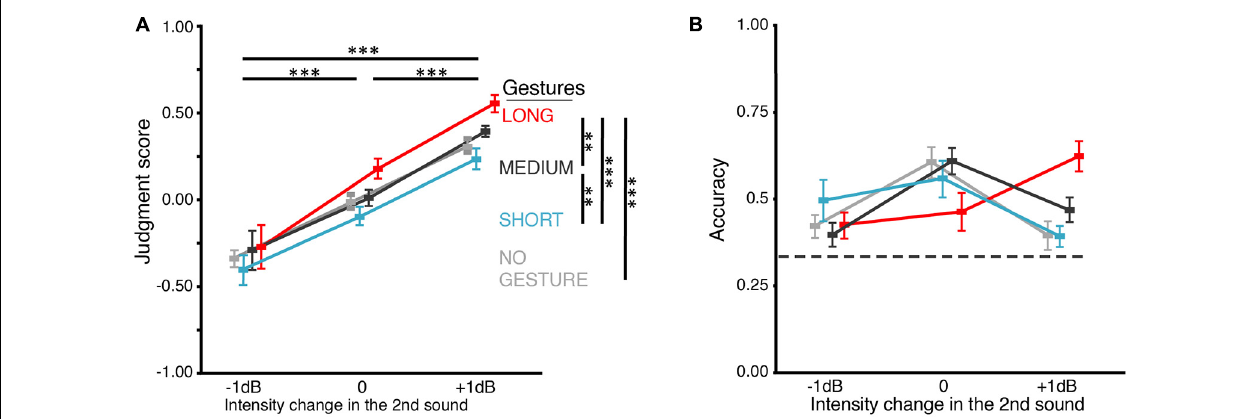
FIGURE 3 | Results of BE2. (A) Judgment score. BE2 investigated how the gestures in still images influenced loudness perception. Because for each of the three gestures, no gesture was shown before the hands showed up, we included a NO-GESTURE as the baseline condition. The loudness judgment was positively influenced by both the intensity change and still gesture. However, the difference was neither significant between MEDIUM and NO-GESTURE nor between SHORT and NO-GESTURE. The influence of still gestures on loudness judgment was smaller than motional gestures in BE1 ( Figure 2A ). In addition, the judgment scores were not different between any pair of gestures in –1-dB intensity change. (B) Accuracy of the behavioral judgments about intensity change. When intensity changes were –1 or 0 dB, no gesture differed in its influence on judgment accuracy, though the overall interaction between the factors of gesture and intensity change was significant. The dashed line indicates the chance level (0.33). All error bars indicate ± one SEM. * p < 0.05; ∗∗ p < 0.01; ∗∗∗ p <